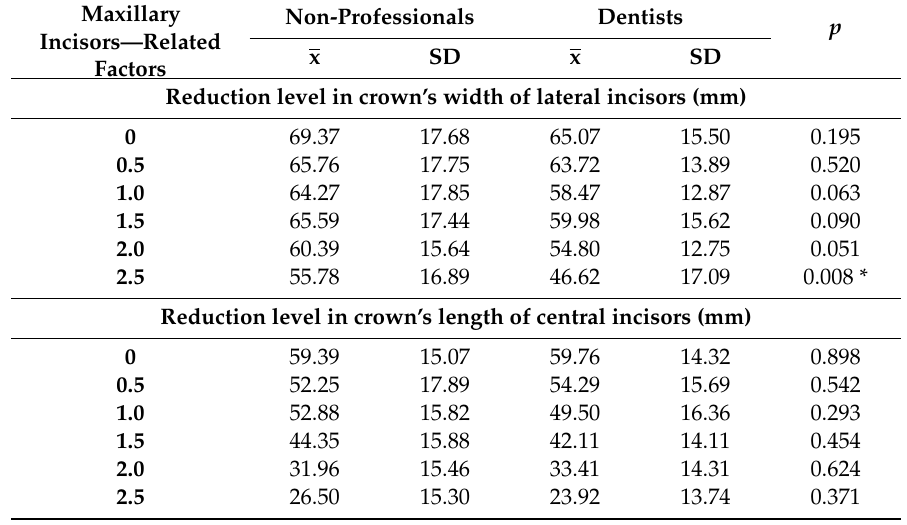
Table 1. Perceptions of dentists and non-professionals towards some maxillary incisors—related